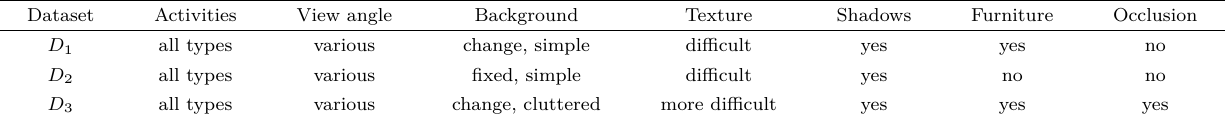
Table 2 Difficulties and challenges of each dataset